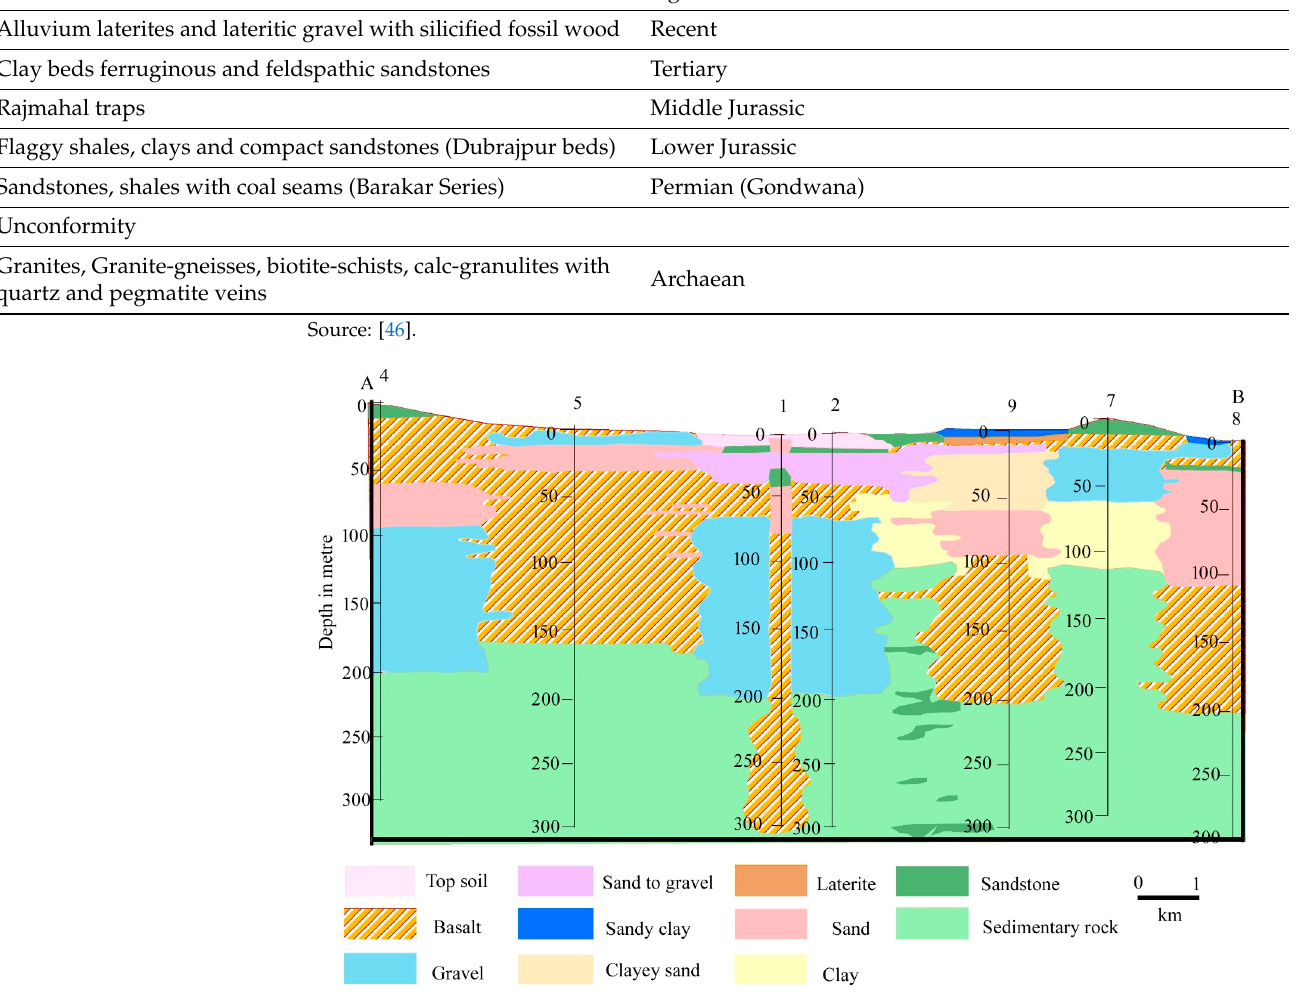
Figure 5. Litho–stratigraphic formation of the study area governing the hydrochemical evolution of the study area. Source: [46].